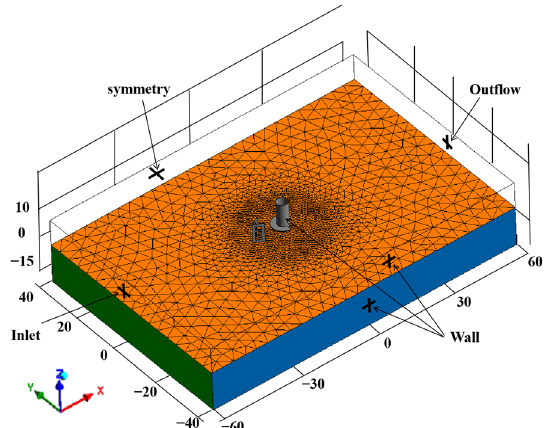
Figure 4. Mesh in computational domain and boundary conditions.